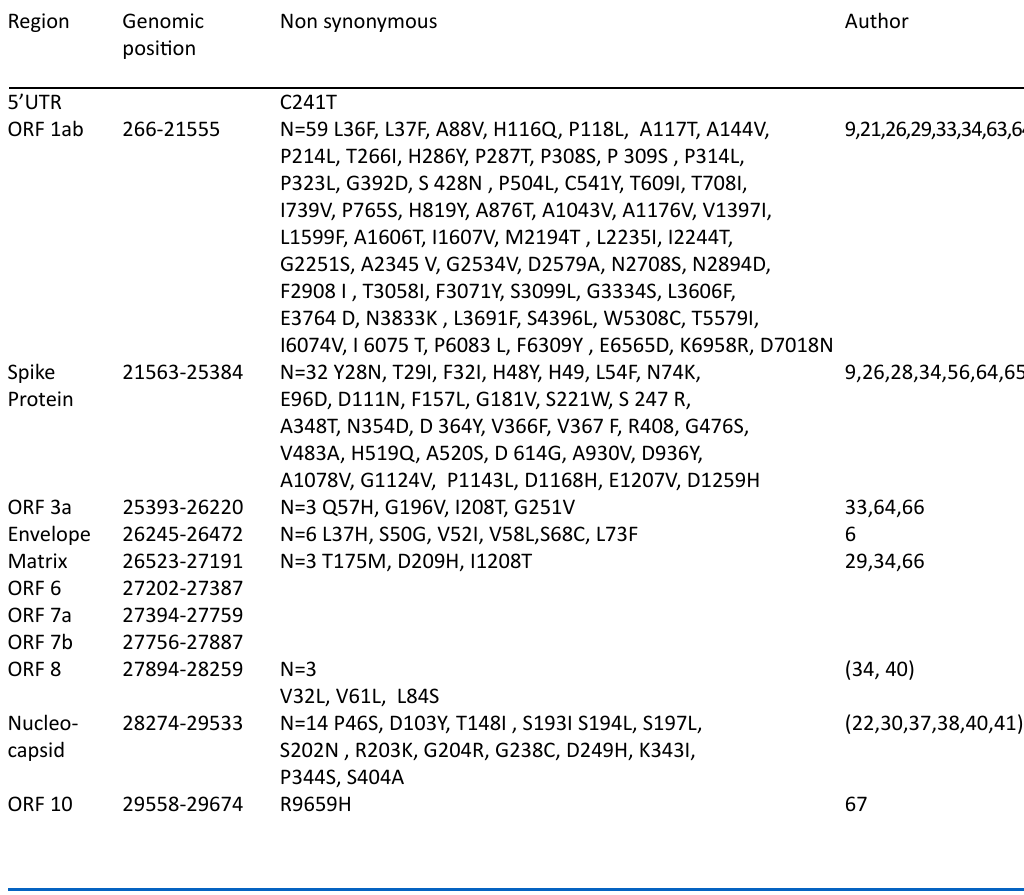
Table 2. Mutations occurring on the SARS-CoV-2 genome